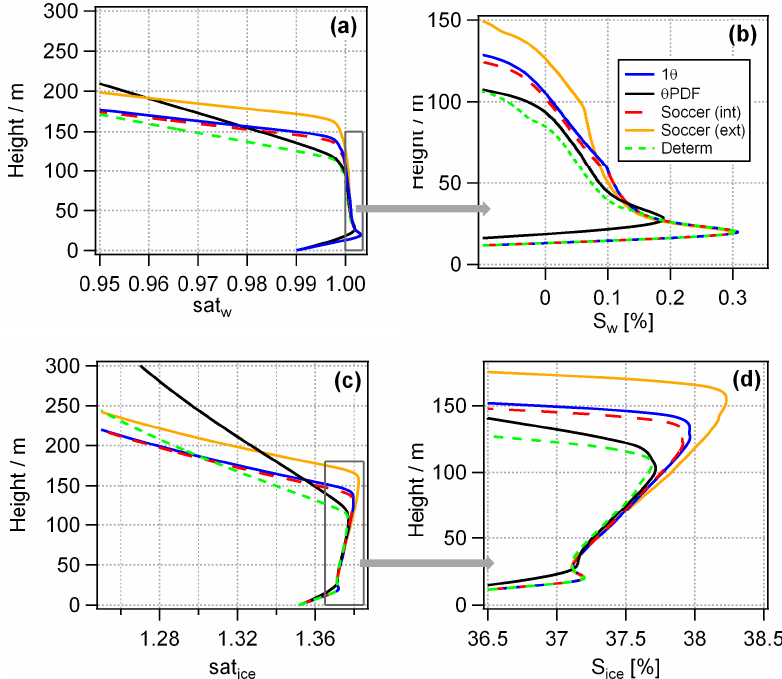
Figure 5. Saturation sat and supersaturation S [%] with respect to (a, b) water and (c, d) ice for the simulations in Figure 4 e, f ( w = 2 cm s -1 ). They grey boxes in (a, c) are enlarged in (b) and (d), respectively, in order to show details of the maximum supersaturation near cloud base where initial ice nucleation occurs.